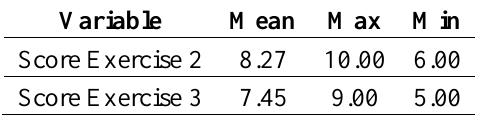
Table 7. Description of scores obtained from Exercises 2 and 3 ( n = 22).